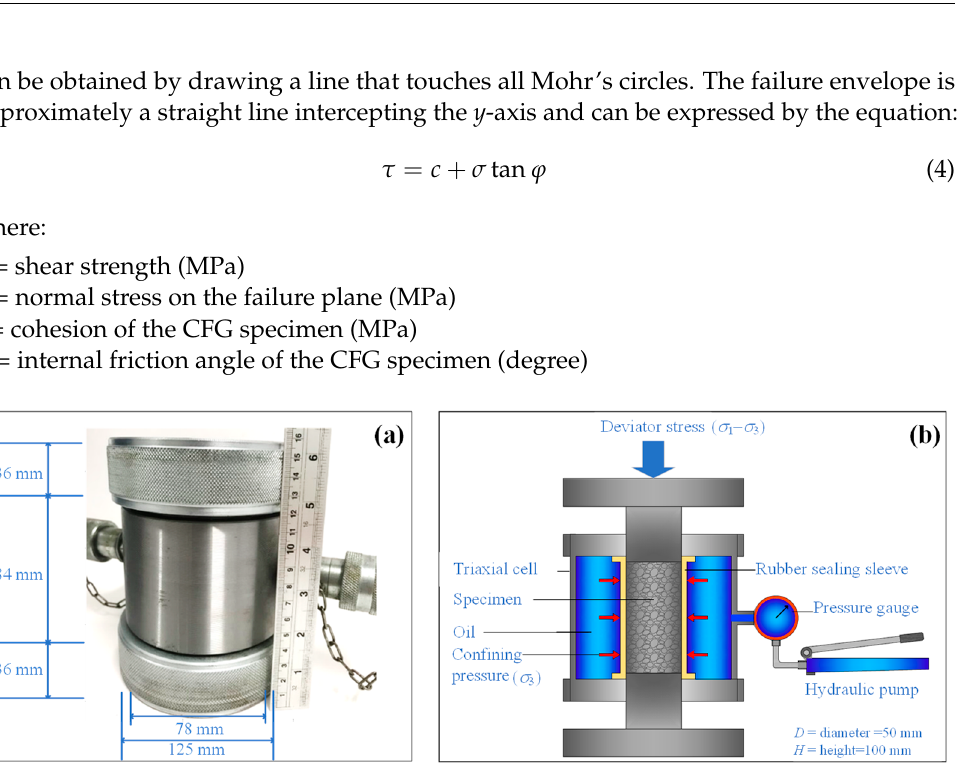
Figure 7. Triaxial test apparatus, including ( a ) Hoek’s cell and ( b ) test setup.